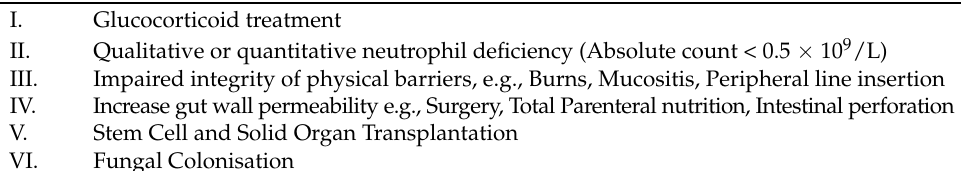
Table 1. Risk Factors for Invasive Fungal Disease